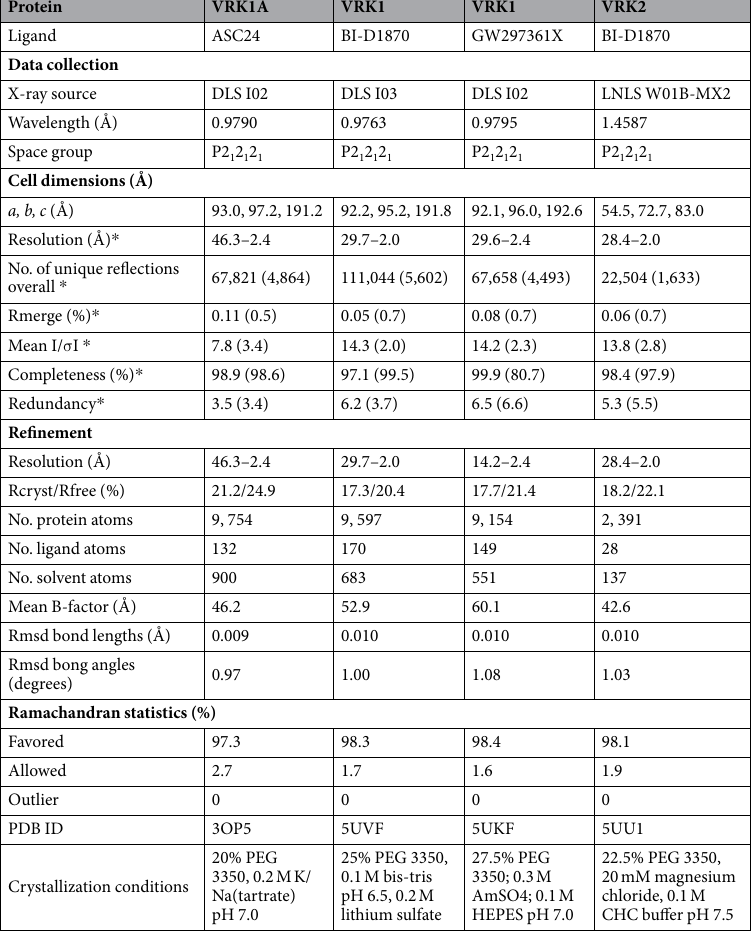
Table 2. Crystallographic